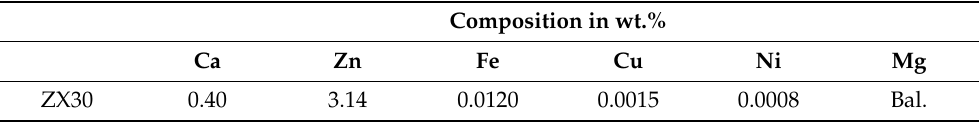
Table 1. Composition in wt.% of the ZX30 magnesium alloy.